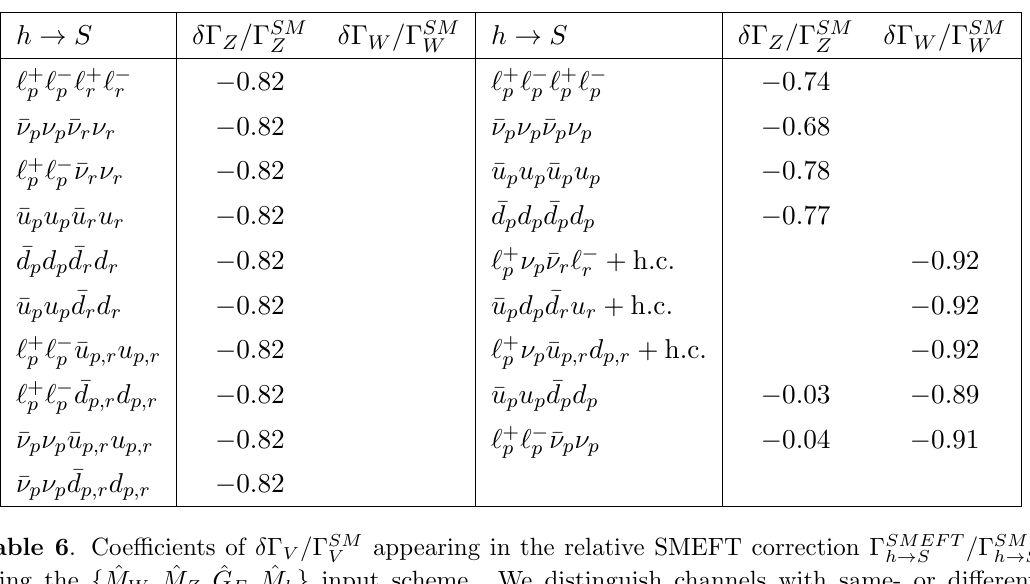
= (cid:0) SM , h ! S h ! S